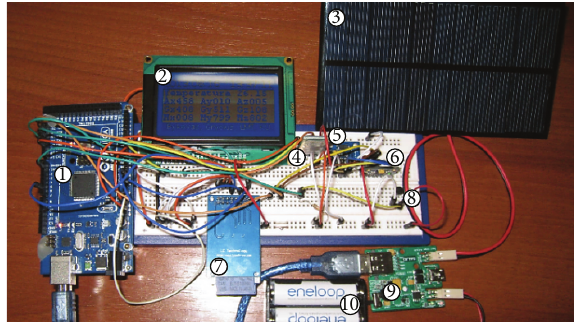
Figure 5: Buoy electronic system prototype.